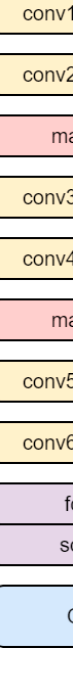
Figure 3. The architecture of UCNet6 for image-based activity recognition. Table 1. The detailed CNN architecture of UCNet6.